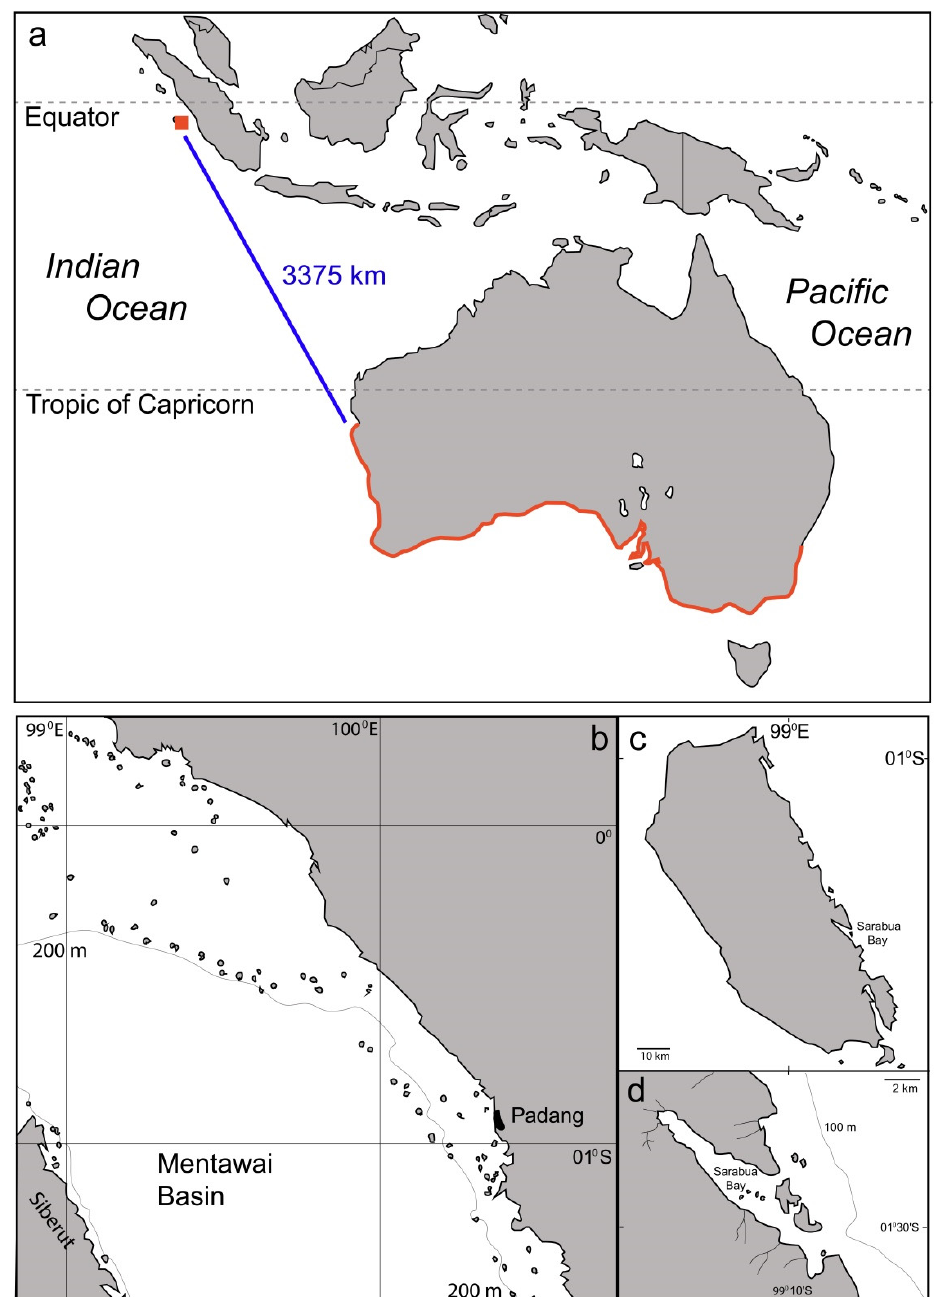
Figure 3. Maps. ( a ) The distribution (red colour) of Coscinaraea marshae in southern Australia [9] and West Sumatra. ( b ) The coastal area of Padang city. ( c ) Siberut Island. ( d ) Sarabua Bay.